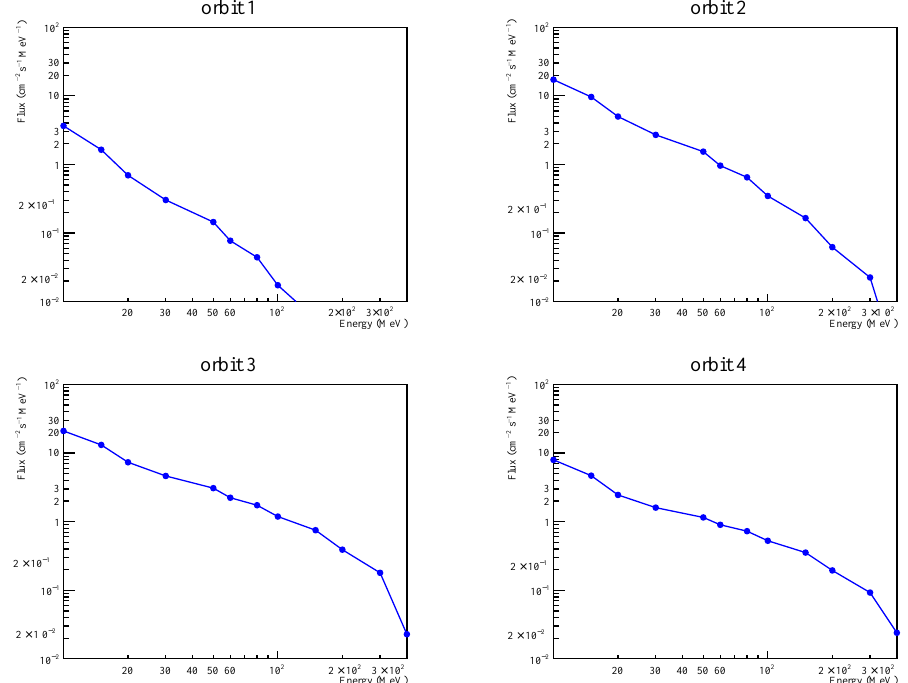
Figure 4. Differential, omnidirectional energy spectra of > 10 MeV trapped protons obtained with the AP9 model and averaged over each CSES-01 orbit (see title above each panel). In each orbit, the spectrum decreases as energy increases, as